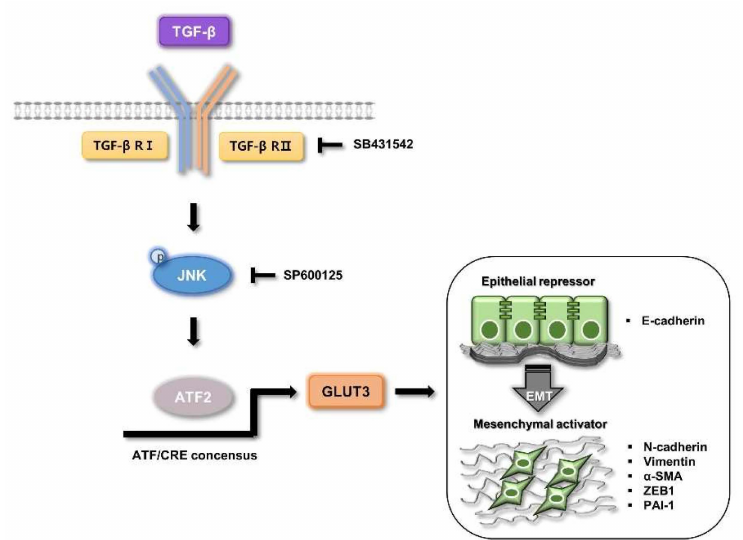
Figure 7. Schematic representation of the regulation of GLUT3 on TGF- β -mediated EMT in CRC cells. Expression of GLUT3 is regulated by the TGF- β /JNK/ATF2 signaling pathways, and overexpression of GLUT3, thereby, exacerbates CRC cells’ invasiveness. “ ↓ ” indicates induction; “ (cid:96) ” indicates inhibition. GLUT3, glucose transporter 3; TGF- β , transforming growth factor- β ; EMT, epithelial– mesenchymal transition; CRC, colorectal cancer; JNK, c-Jun N-terminal kinase; ATF2, activating transcription